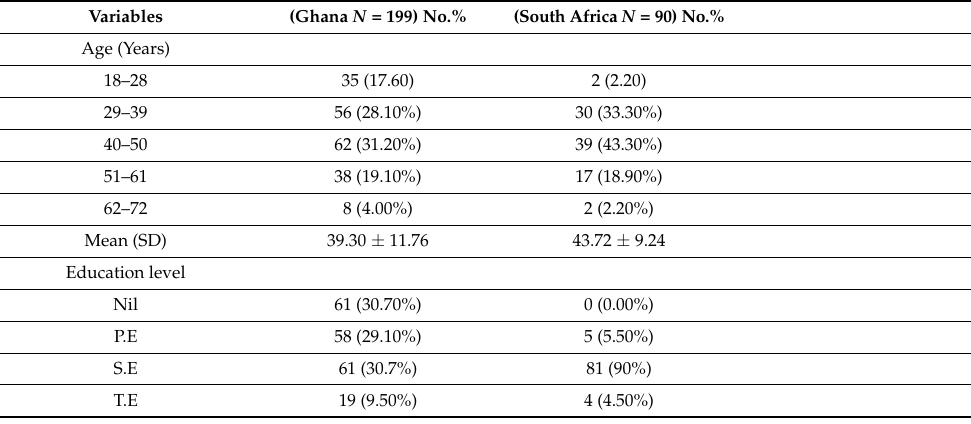
Table 1. Socio-demographic characteristics of Ghanaian and South African market women.